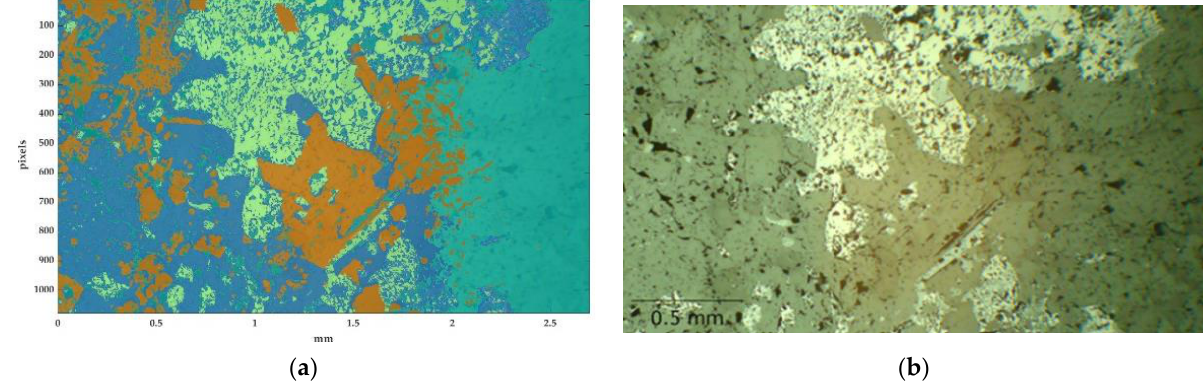
Figure 9. SOM segmentation image ( a ): cyan = 32% (mixed phases); brown = 19% (quartz); blue = 34% (tourmaline); green = 16% (magnetite and goethite). Reflected light image ( b ) for comparation. Long side is 2.7mm.